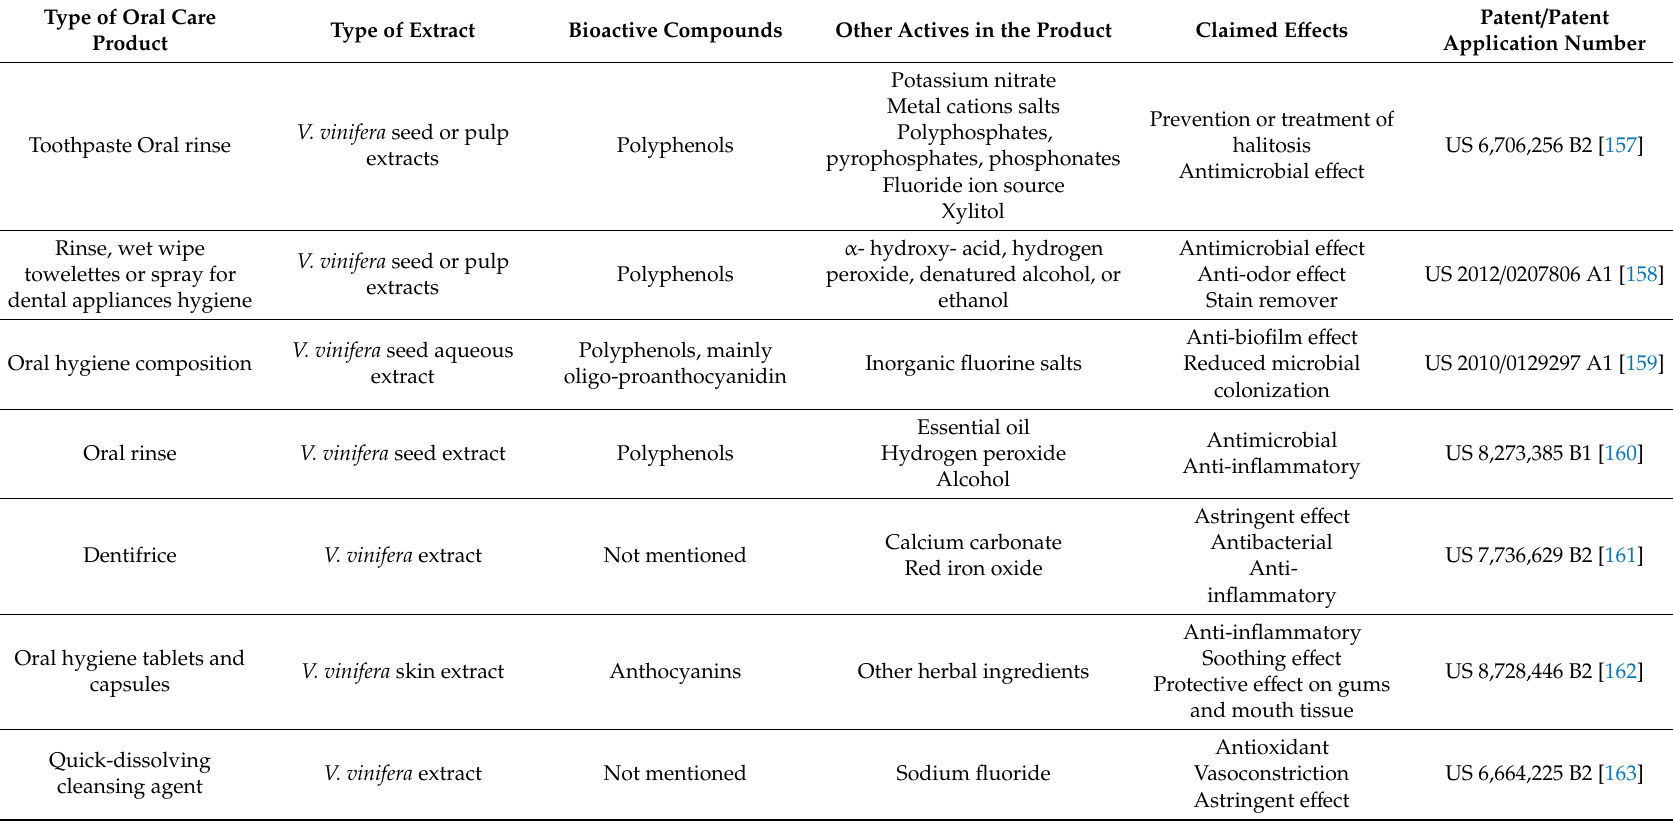
Table 4. Patents / patent applications for oral care products containing V. vinifera